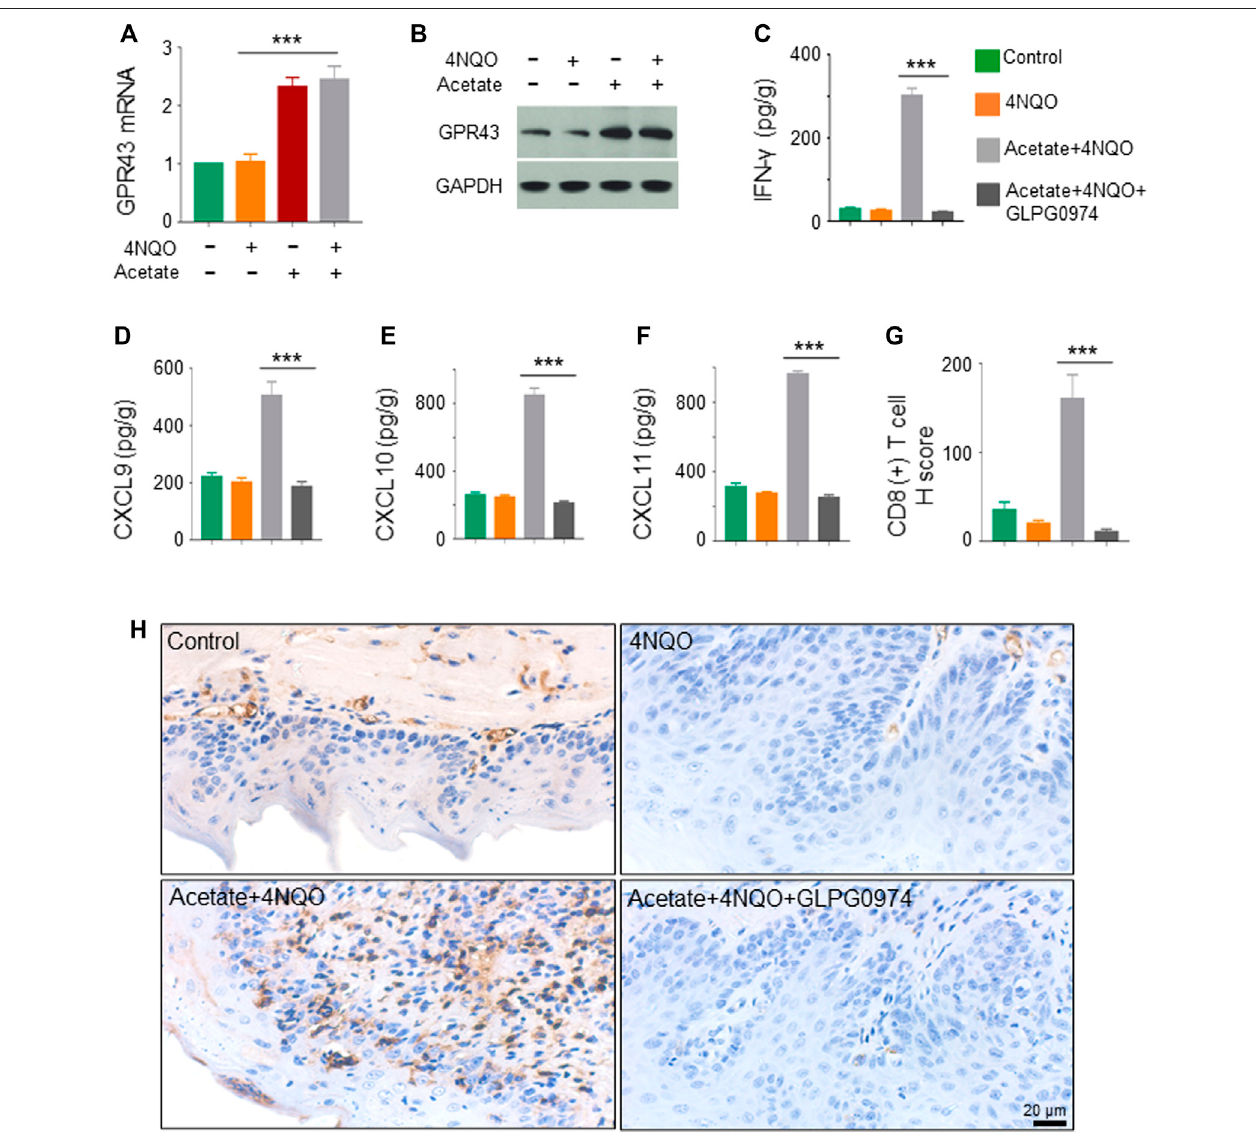
FIGURE 7 | Lactobacillus metabolites promote the expression of IFN-inducible chemokines through activating GPR43. The mice were treated as described in Figure 5 . GPR43inhibitor GLPG0974 (HY-12940, MCE, Monmouth, NJ, United States) was dripped into the oral cavity ofmice at adose of10 mg/kg, once a week for 16 consecutive weeks. Glossopharyngeal tissue was collected for histological staining and cytokine detection. The secretion of IFN- γ , CXCL9, CXCL10 and CXCL11 from tissues was detected by ELISA. (A,B) Transcription (A) and expression (B) of GPR43 in the glossopharyngeal tissue. (C – F) The level of IFN- γ , CXCL9, CXCL10andCXCL11intheglossopharyngealtissue. (G,H) CD8 + TcellsintheglossopharyngealtissuebyIHCstaining.IHCquantitation (G) andrepresentativestaining of CD8 + T cells in glossopharyngeal tissue (H) were presented. Data represent mean ± SEM.*** p < 0.001, n = 5, compared with Acetate+4NQO + GLPG0974.